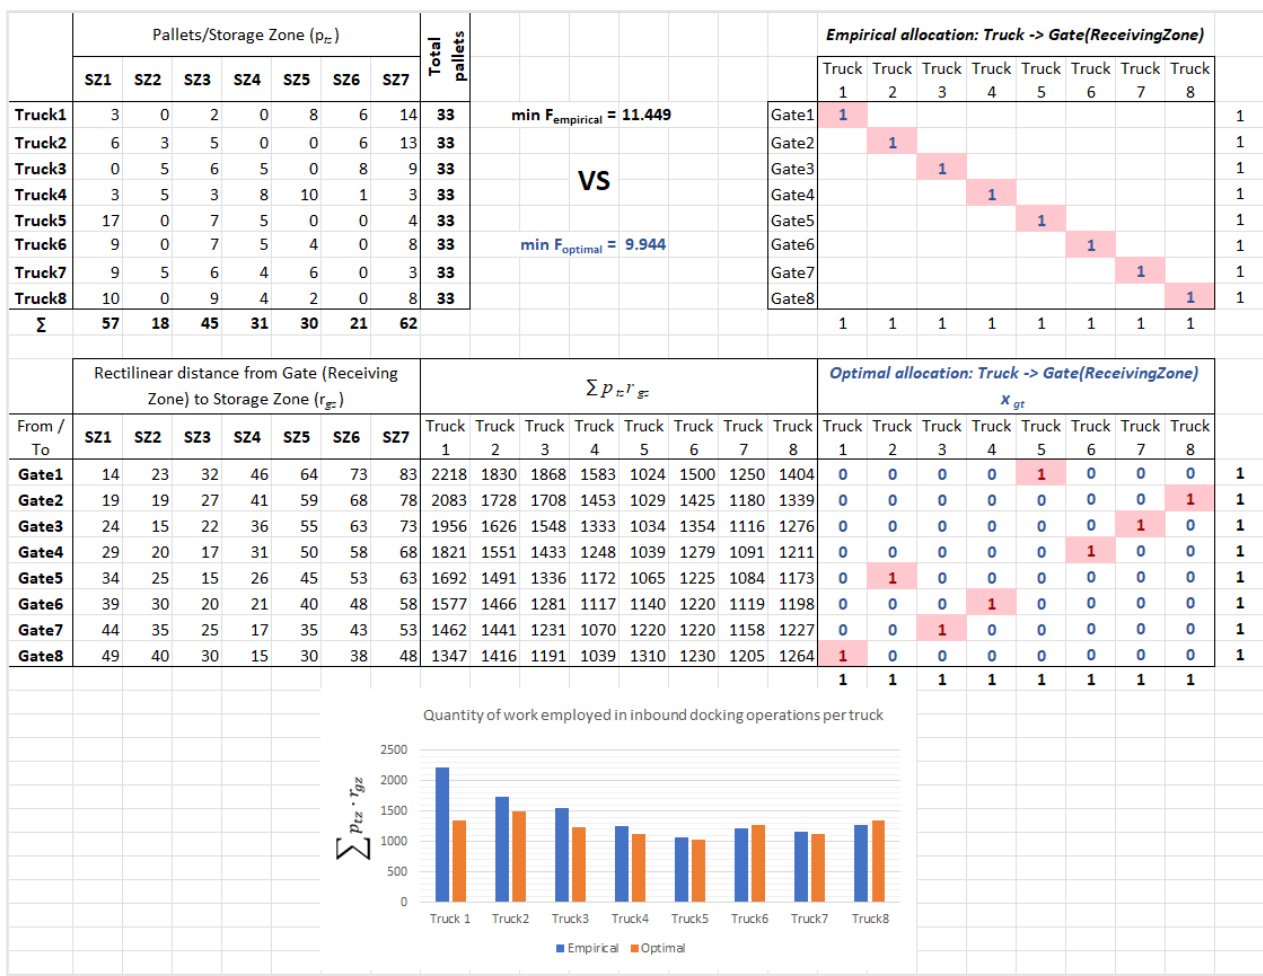
Figure 2. Empirical vs. optimal inbound dock door allocation.